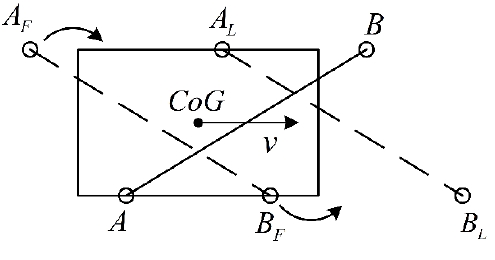
Figure 13. Movement of CoG.